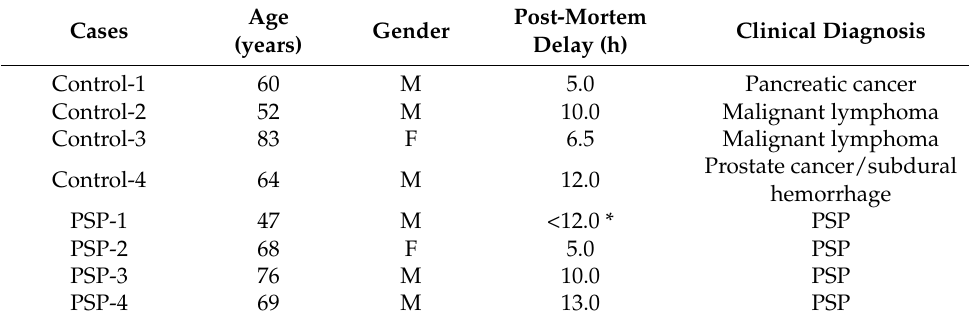
Table 3. Clinicopathological data of the individual cases included in this